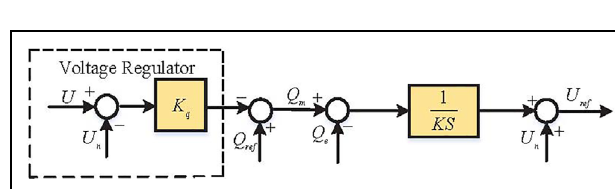
FIGURE 3 | Control modules of reactive power control module.